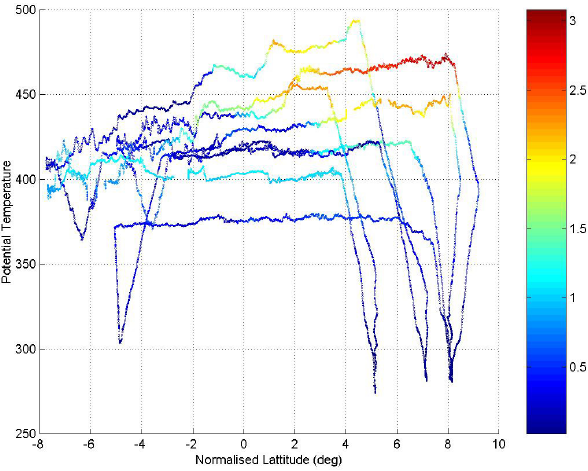
Fig. 2. Ozone as a function of potential temperature and latitude, relative to the edge of the chemically perturbed region above 415 K, for all flights.